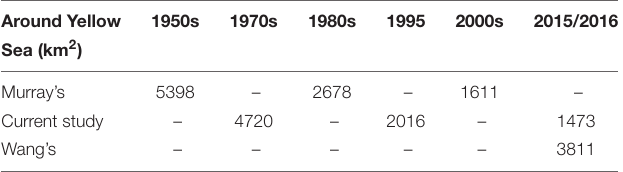
TABLE 6 | Extent of intertidal wetlands around the Yellow sea from different studies. Around Yellow